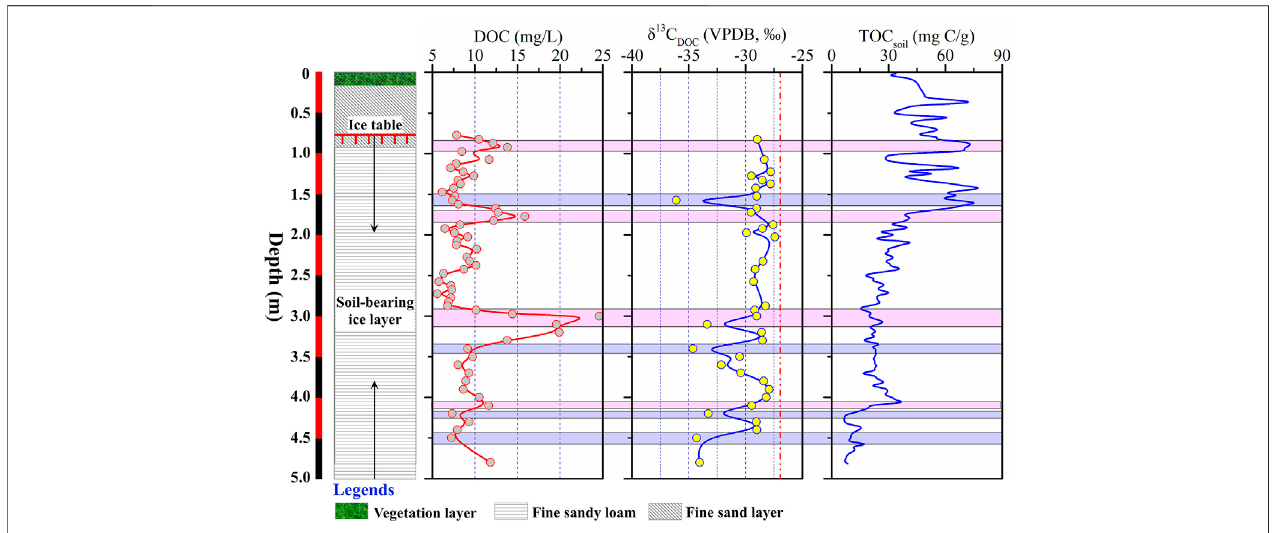
FIGURE 3 | Variations in DOC and δ 13 C DOC of ground ice and (total organic carbon) TOC of soil along depth in P-1. The pink bars represent four peaks of DOC in ground ice and the corresponding values of δ 13 C and TOC soil . The blue bars denote the lower DOC and more negative δ 13 C values.